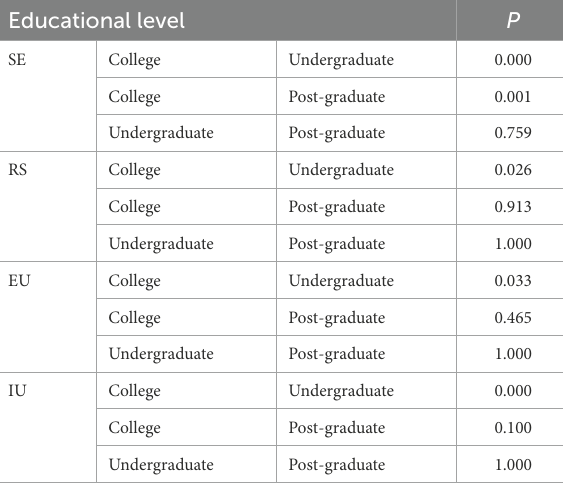
TABLE 5 Pairwise multiple comparisons for educational